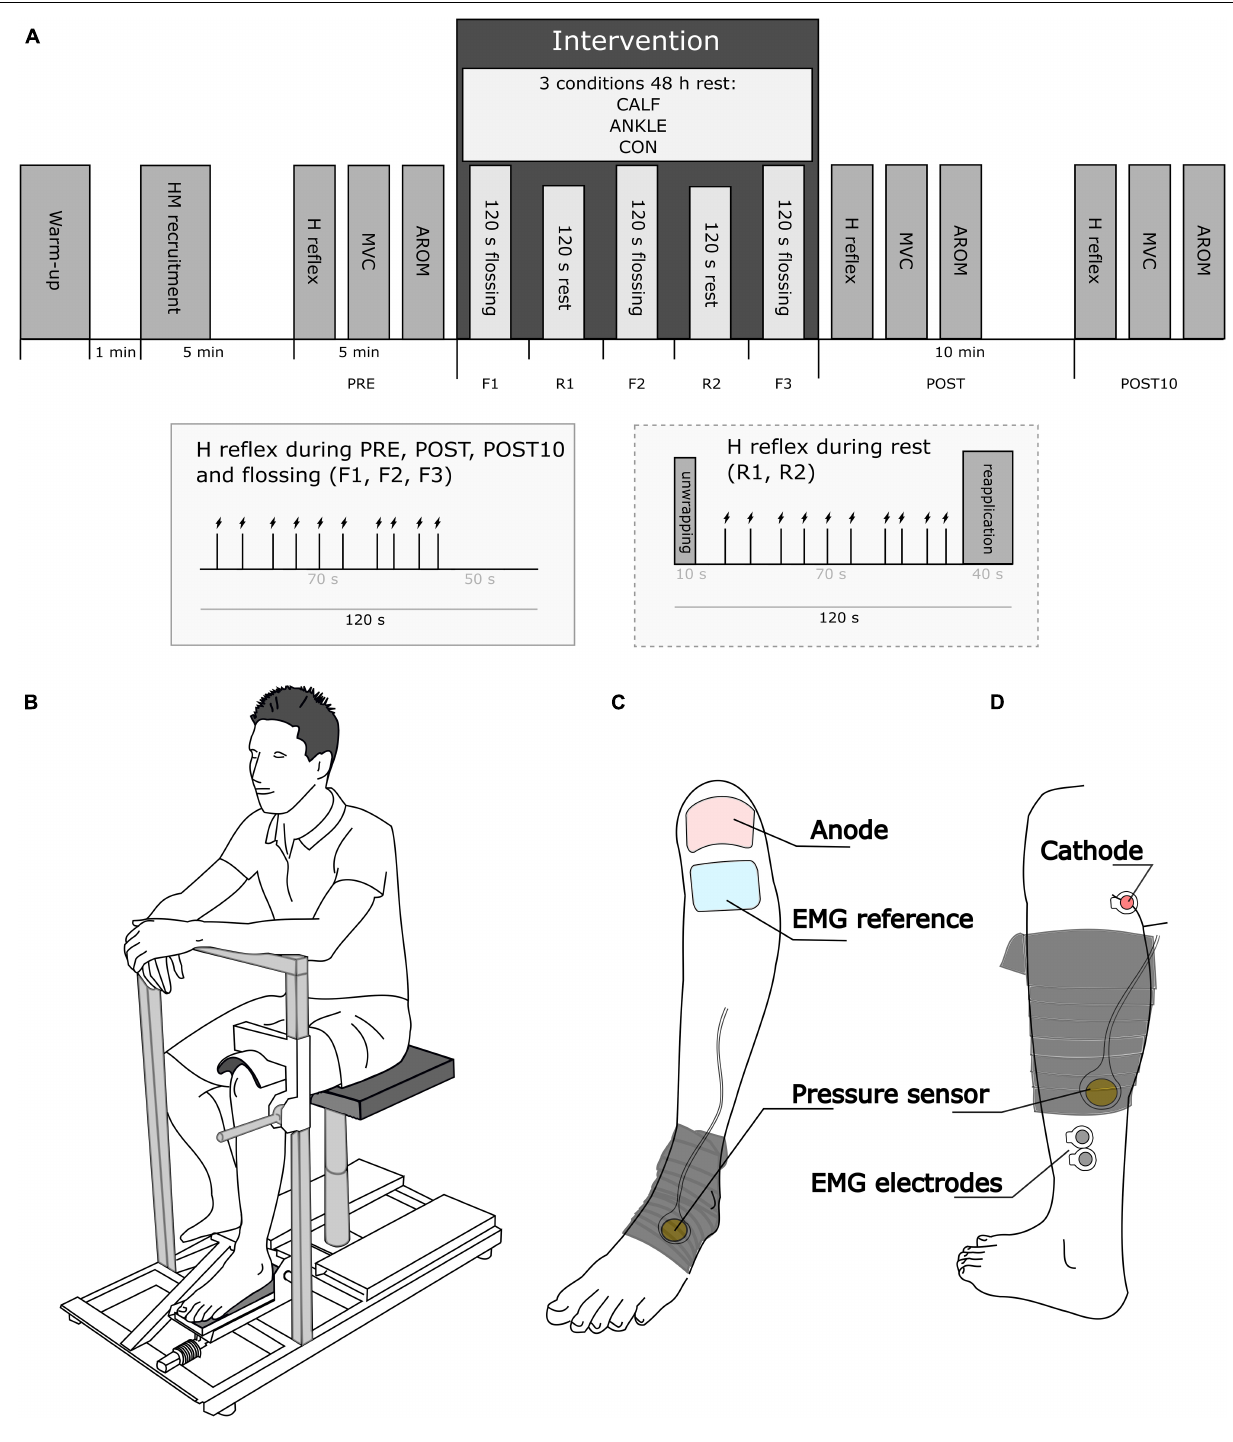
FIGURE 1 | (A) Graphical representation of the study design. AROM and MVC were assessed before (PRE) and after the intervention (POST and POST10). The H reflex was assessed during the flossing and control intervention (F1, F2, F3) and in the rest periods between flossing and control interventions (R1, R2). The small box captions represent the timeline of nerve stimulation during PRE, F1, F2, F3, POST, POST10, and R1, R2, respectively. (B) Schematic of the position of the subject during the neuromuscular assessment. (C) Flossing band wrapping during the ANKLE condition; (D) flossing band during the CALF condition. (C,D) Show the placement of the pressure sensor probe, EMG and stimulation